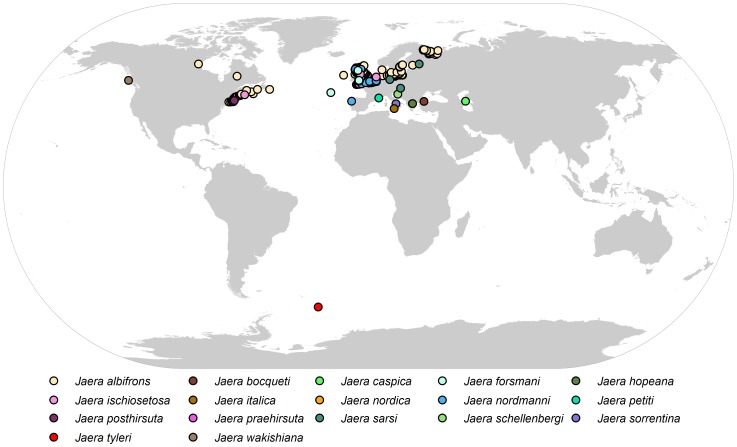
Global distribution of Jaera.